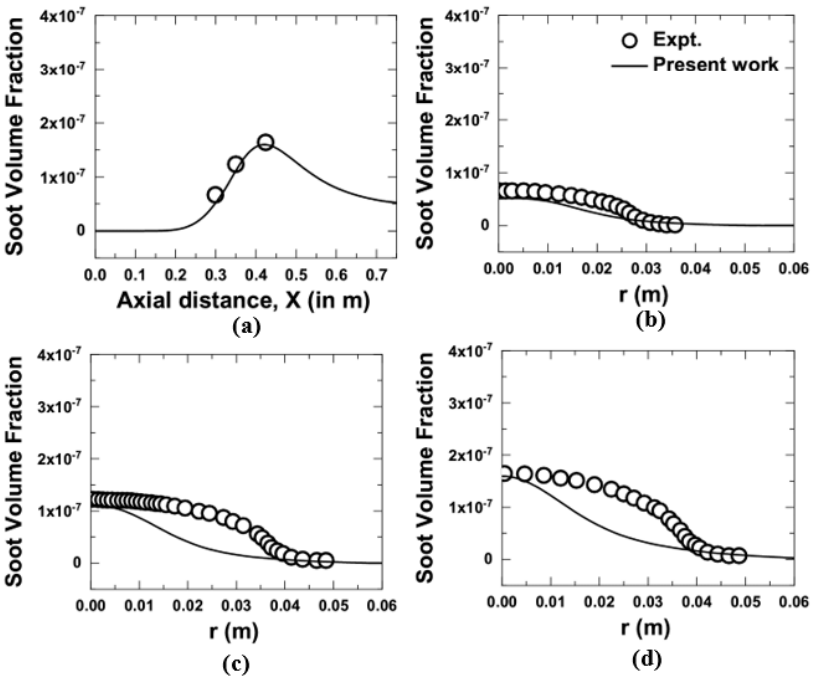
Figure 5. Comparison of soot volume fractions obtained from the present numerical model with the measurements [10] at 1 atm; ( a ) axial variation, and ( b ), ( c ), ( d ) radial variation at an axial location of 0.3 m, 0.35 m, and 0.425 m, respectively.